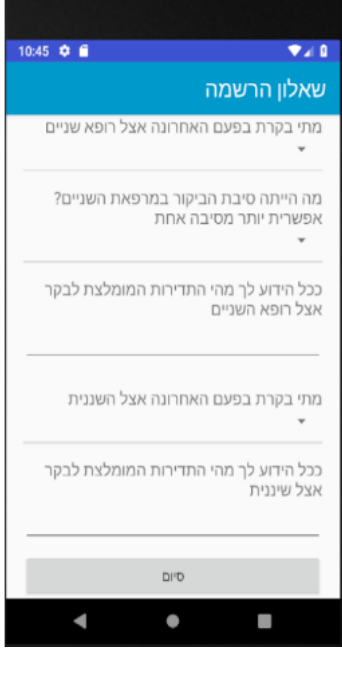
Figure 10. Registration questionnaire screen for the patient: oral hygiene,